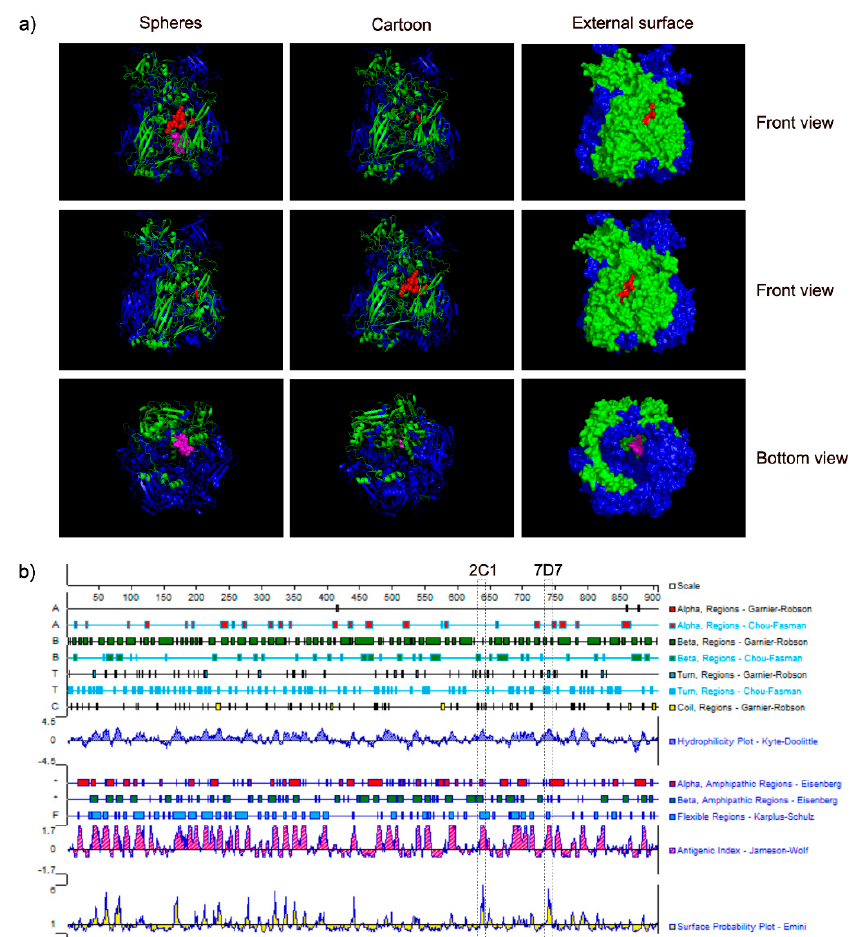
Figure 5. Spatial structure and positions of the identified epitopes. ( a ) Relative locations of the identified epitopes are presented in spherical, cartoon and external surface depictions of monomer hexon from a 3D structure of CAdV-2 trimeric hexon that was predicted using the SWISS-MODEL online service. Epitopes recognized by mAbs 2C1 and 7D7 are shown in red and purple, respectively, separately, and from the front view and the bottom view. ( b ) Secondary structure features of the CAdV-2 hexon were predicted using PROTEAN software. The putative 2C1 and 7D7 epitopes are shown in the boxes.